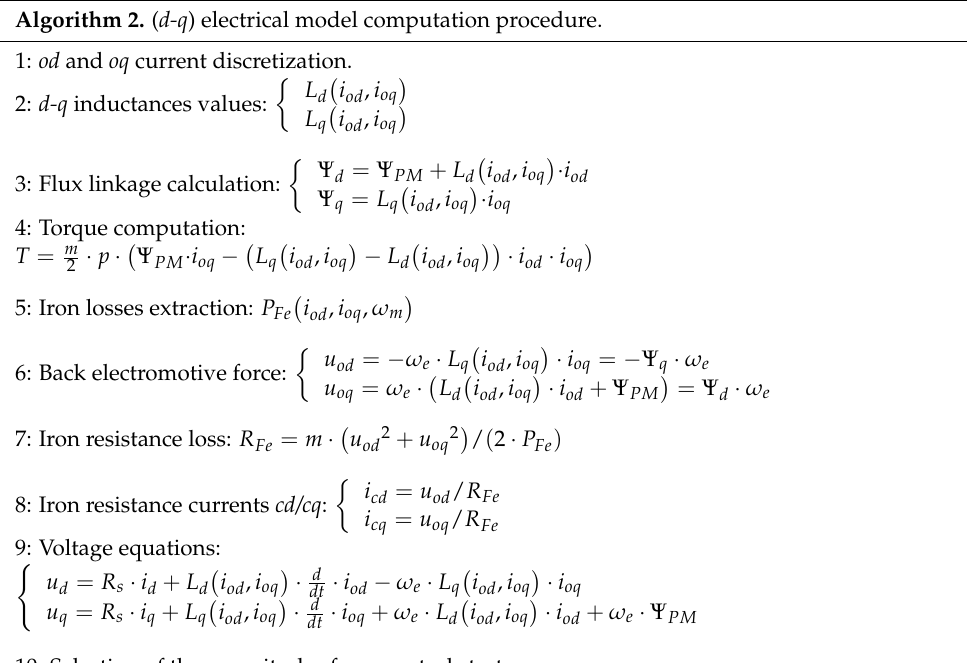
Algorithm 2 details the d-q electrical model computation procedure applied to extract the torque-speed-efficiency maps from the data estimated from the experiments. Algorithm 2. ( d-q ) electrical model computation